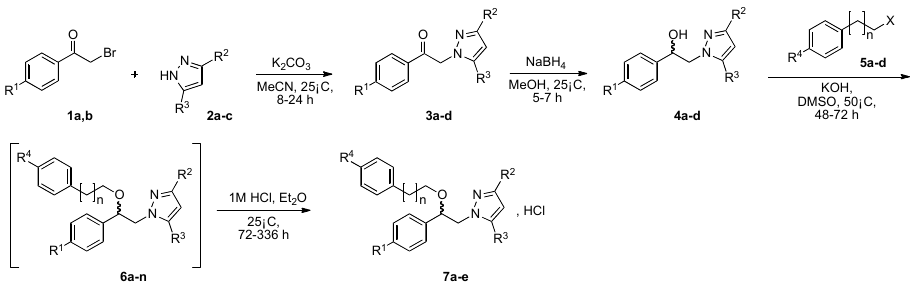
Table 2. Optimization of the reaction conditions for the preparation of the intermediates 6a – n . Reagent 5 for KOH (Number Entry Starting Compound 4 O -alkylation of Equiv.)